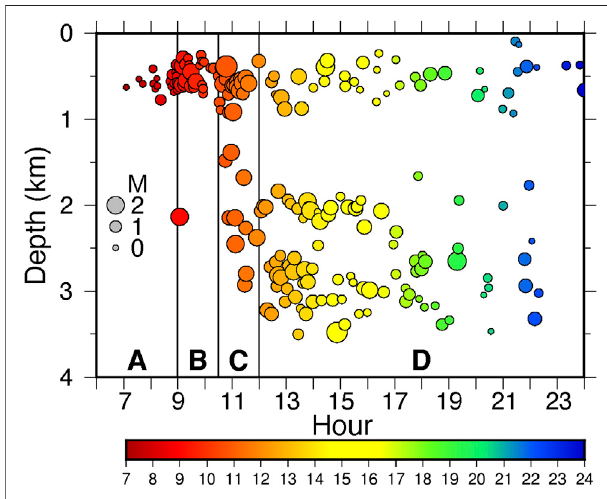
FIGURE 10 | Temporal change of the hypocenter depth of the VT earthquakes on August 15, 2015. The colors indicate the occurrence time as Figure 7 . The size of the circle is proportional to the magnitudes of the VT earthquakes. The vertical lines indicate 9:00, 10:30, and 12:00 JST. The letters A, B, C and D represent the time